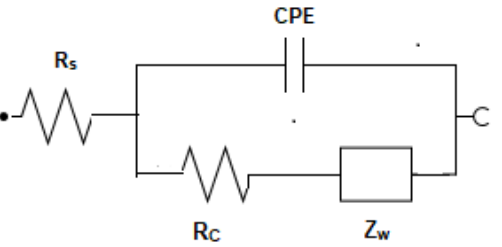
Figure 2. Optimization of N protein immobilization time: ( A ) Cyclic voltammograms in 5 mmol L − 1 [Fe(CN) 6 ] 3 − /4 − + 0.1 mol L − 1 KCl; ( B ) plots of Ipa ( μ A) versus tempo (min).